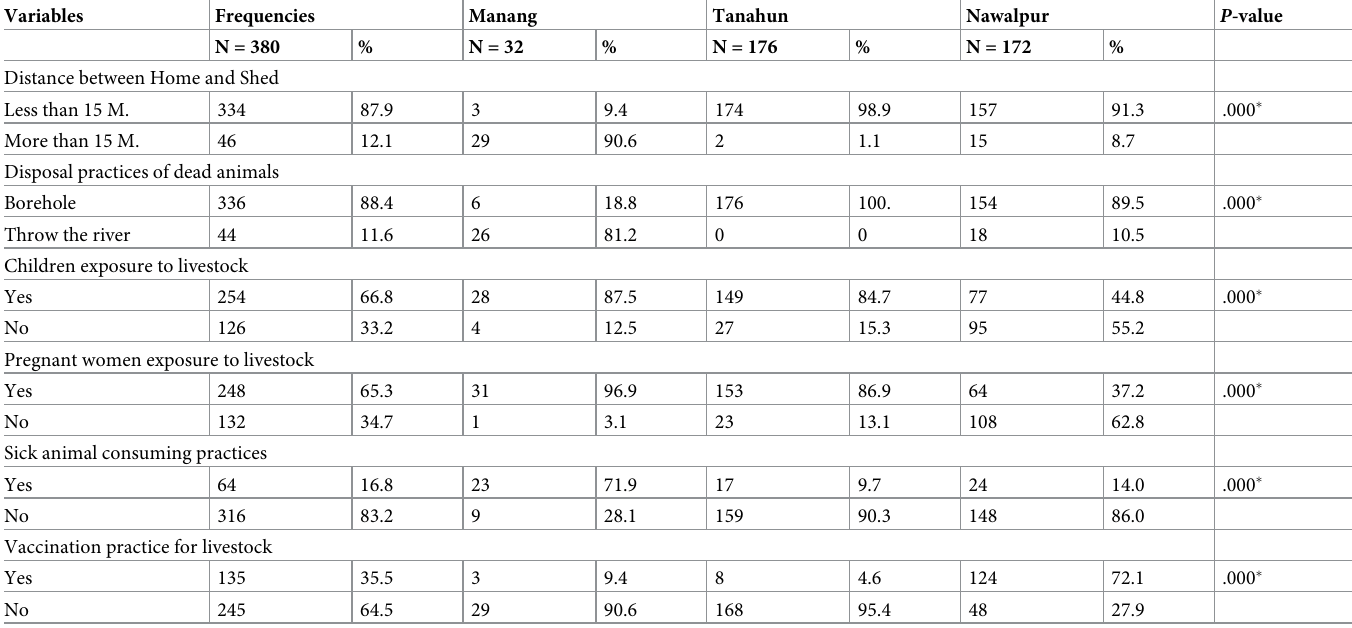
Table 6. Livestock related common practices based on ecological regions of the respondents’.